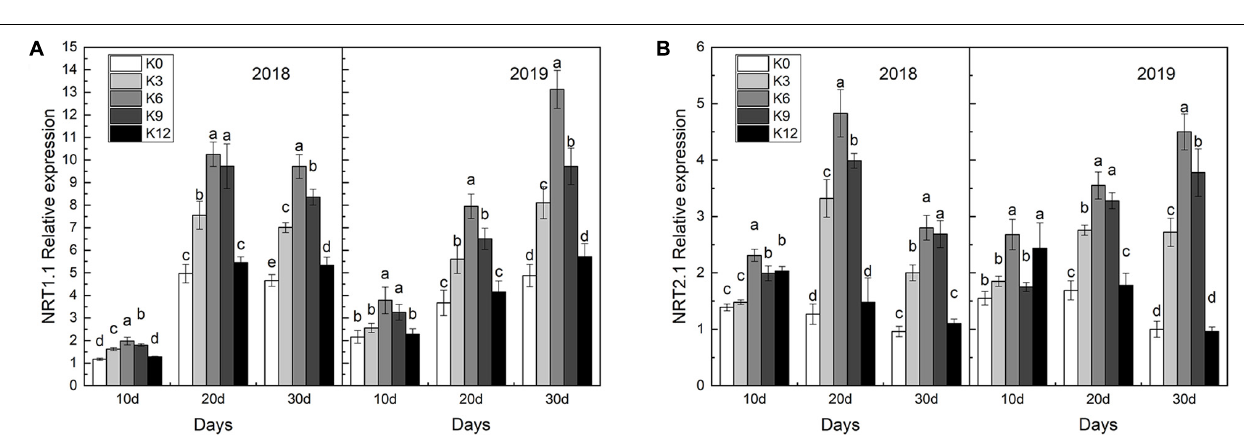
FIGURE 7 | NRT1.1 gene expressions (A) and NRT2.1 gene expressions (B) in the roots of M9T337 seedlings treated with K0 (0 mM K + ), K3 (3 mM K + ), K6 (6 mM K + ), K9 (9 mM K + ), or K12 (12 mM K + ) in 2018 and 2019. Each treatment had three biological replicates and the assays were repeated three times. Vertical bars indicate ± SD ( N = 3). Different letters indicate statistically significant differences ( P <